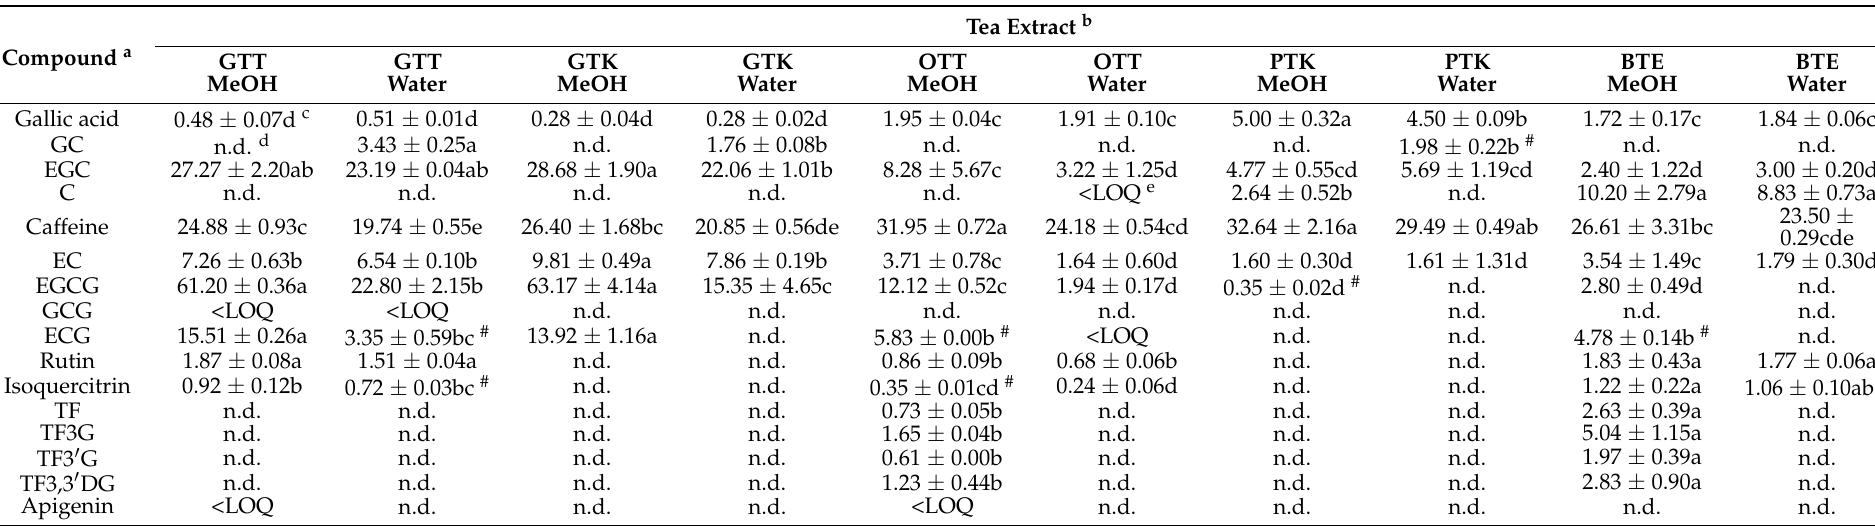
Table 2. Concentrations (mg/g) of phenolics and caffeine in commercial teas as determined by an HPLC system equipped with a UV detector (processed by Python code).